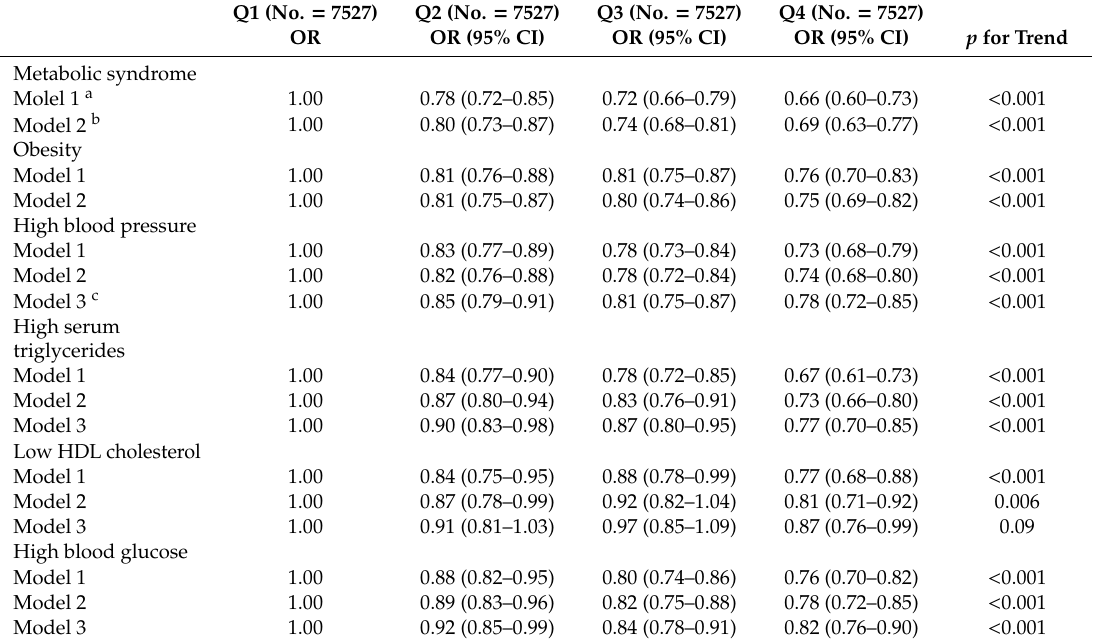
Table 3. Associations of Factor 1 (fiber, potassium and vitamins pattern) scores with metabolic syndrome and its